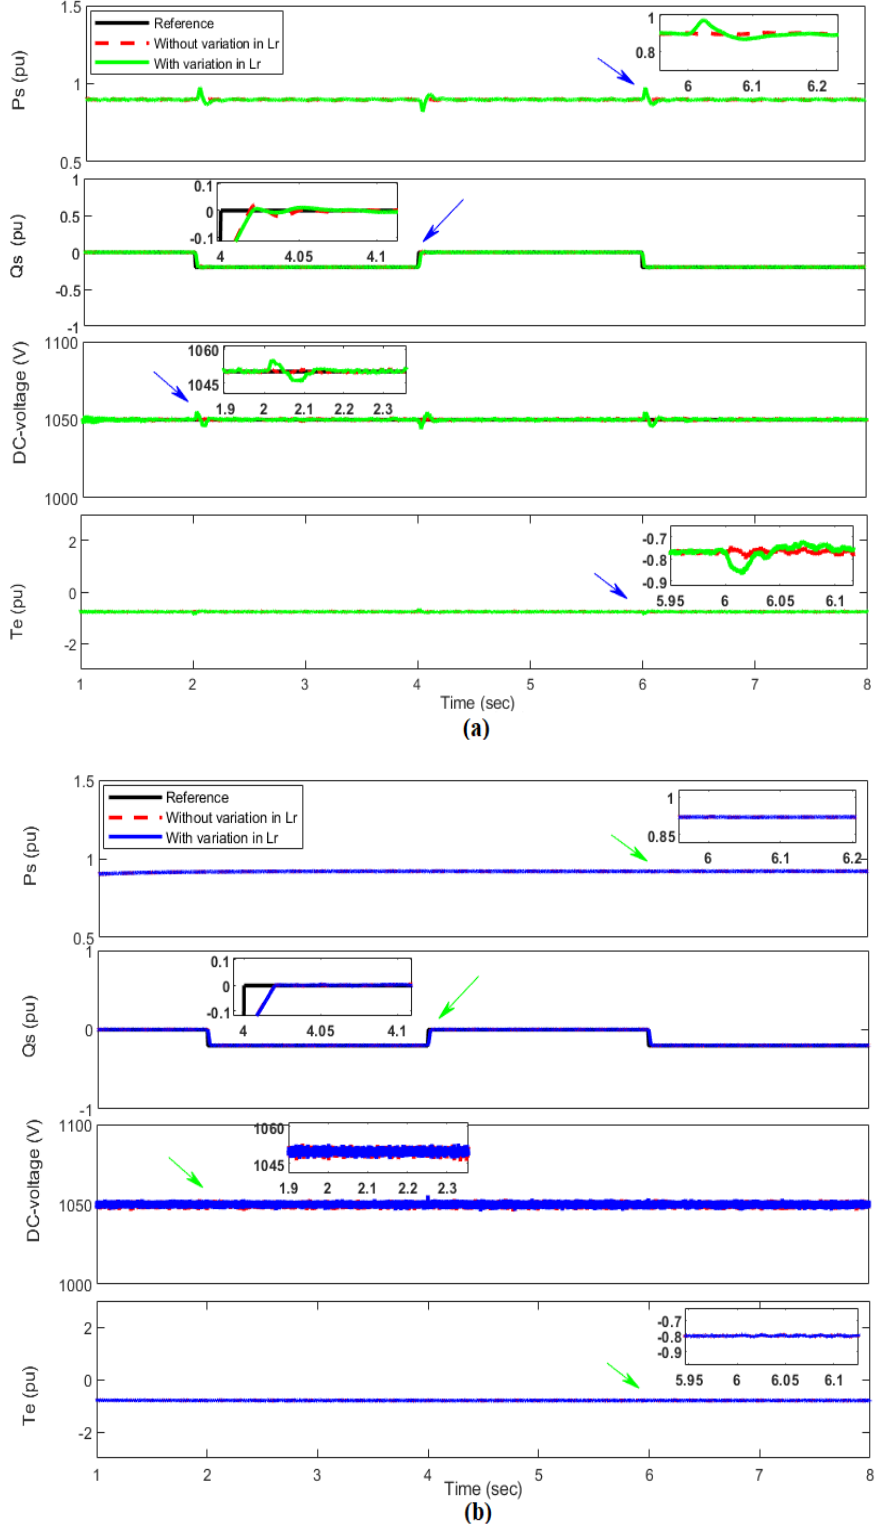
Figure 11. Simulation results of di ff erent control dynamics under the influence of rotor inductance variations: ( a ) PI controller; ( b ) STA-SOSM controller.